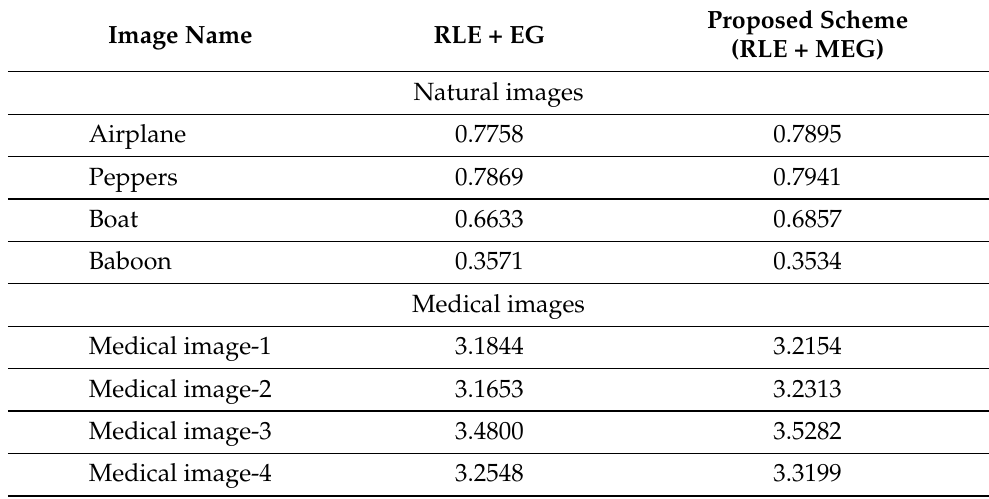
Table 2. Comparison of embedding rate (in bpp) with the RLE + EG